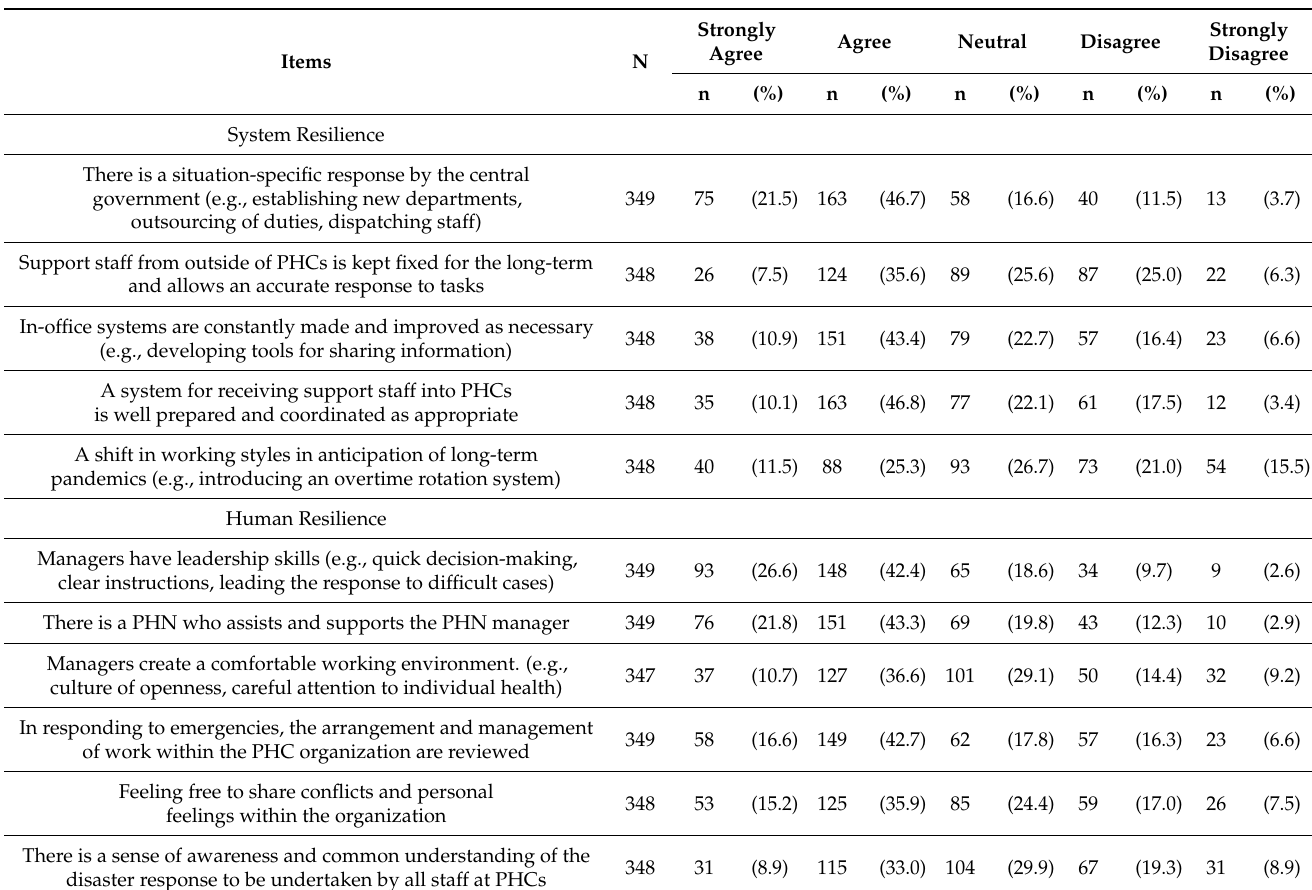
Table 4. Perceived organizational resilience rate of each